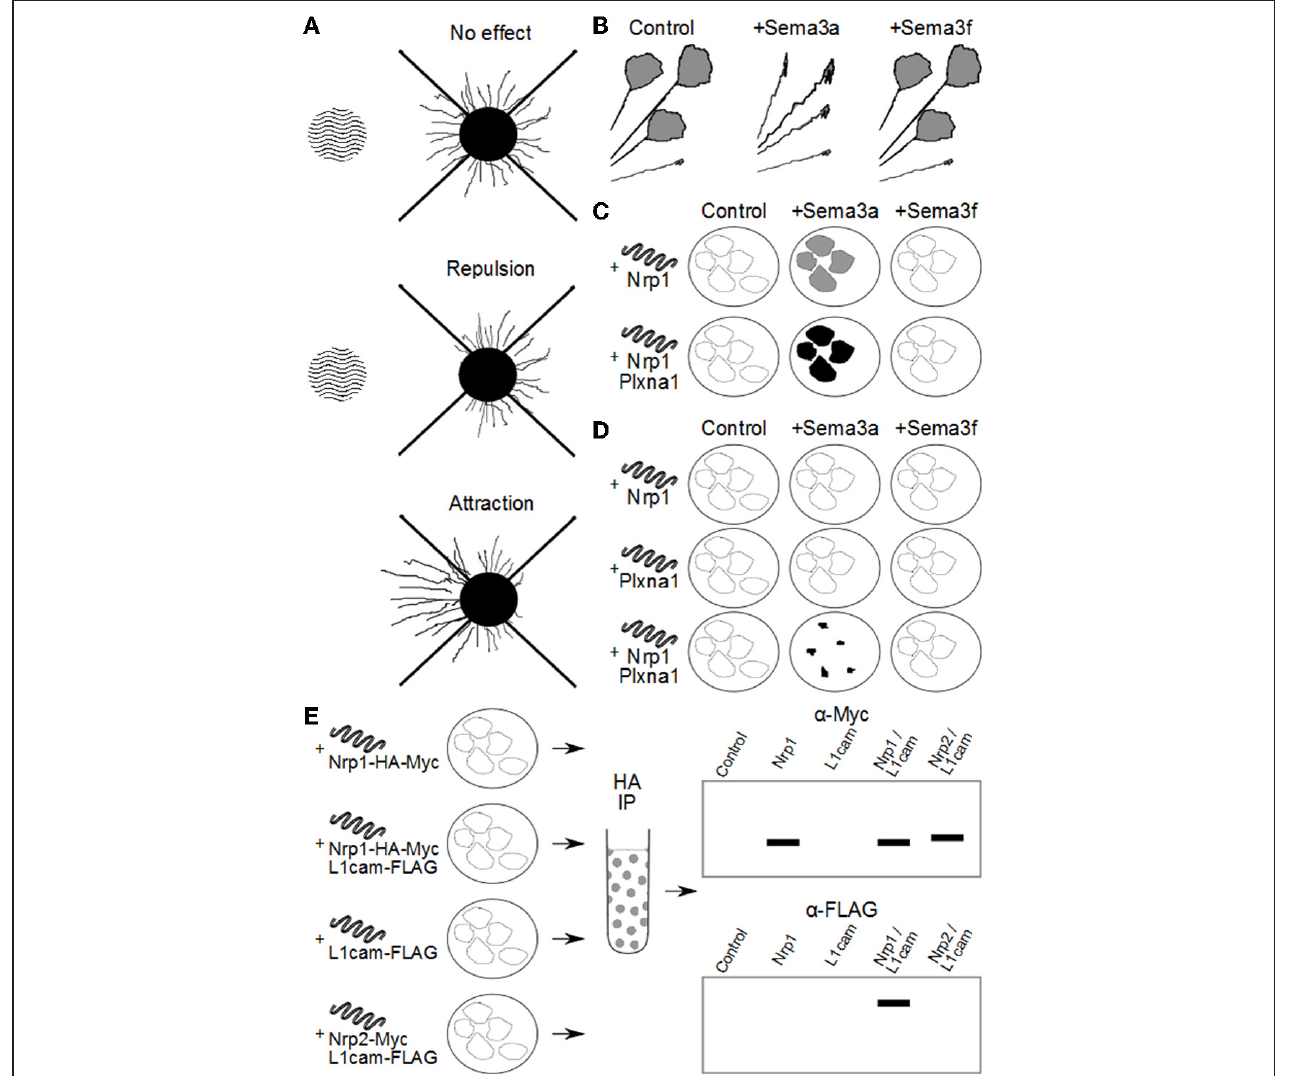
FIGURE 1 | Methods used to investigate Sema3 receptor components. (A) Attraction/repulsion assay. The area of wavy lines represents aggregates of COS/HEK-293 cells over-expressing a Sema3. To the right is neuronal tissue with outgrowth of neurites. In this assay, the average or total lengths of neurites in the proximal and distal quadrants of the neuronal tissue (with respect to the COS/HEK-293 cell aggregates) are compared to quantify the amount of attraction or repulsion. (B) Neurites in vitro with active growth cones are exposed to exogenous Sema3 or vehicle. Changes in the percentage of active to collapsed growth cones are used to determine the biological activity of the Sema3s on different neuronal types. In this example, neurites are found to collapse in the presence of Sema3a but not Sema3f . (C) COS/HEK-293 cells are transfected to ectopically express one or more putative Sema3 receptor components. These cells are then exposed to exogenous recombinant Sema3 which includes an artificial conjugate, most often alkaline phosphatase. After incubation at 4 ◦ C the cultures are washed and stained either by immunocytochemistry, or direct application of a chromagen that interacts with the artificial conjugate (for example NBT/BCIP with alkaline phosphatase). The intensity of staining is proportional to the binding kinetics of the recombinant Sema3 to the putative receptor components and/or complexes, and the dissociation constant can be derived by Scatchard analysis. In this way researchers can compare the relative